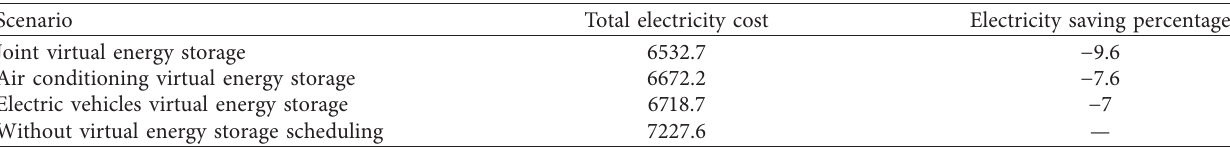
Figure 21: Output power of virtual energy storage with independent participation of electric vehicles in Scenario3. Table 3: Comparison of the total electricity cost within one day for the constant temperature building in residential area number 1 under four scenarios.